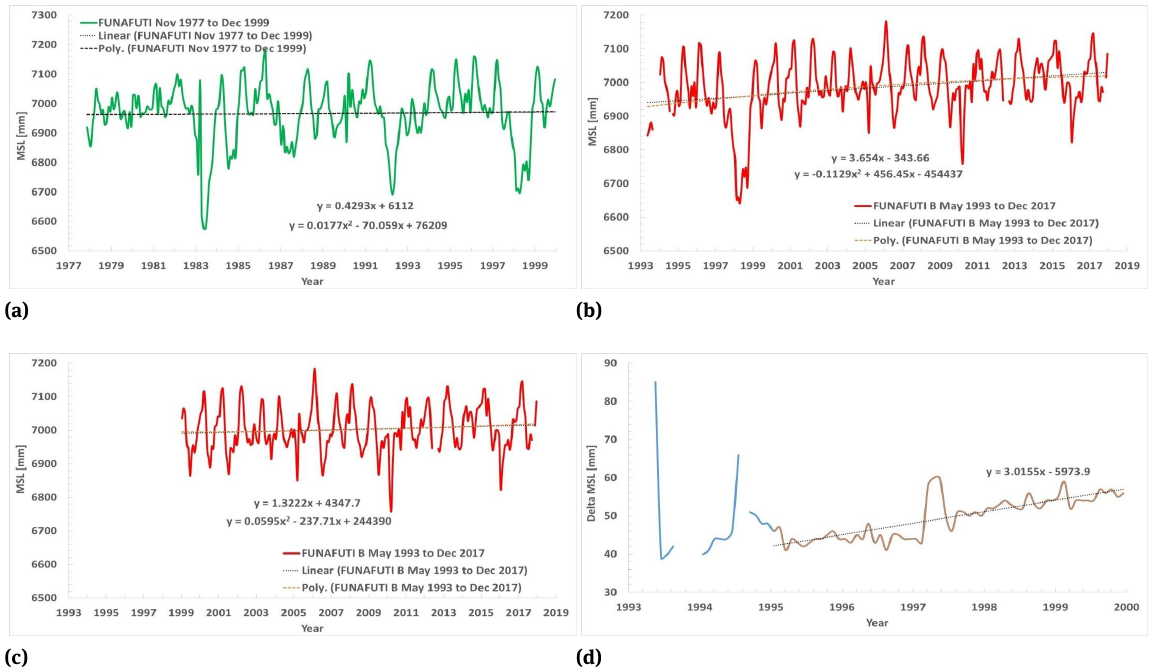
Figure 11: (a) Analysis of the FUNAFUTI tide gauge record; (b) Analysis of the FUNAFUTI B tide gauge record; (c) Analysis of the FUNAFUTI B tide gauge record with starting date Jan. 1999, after the end of the low ENSO waters; (d) differences in between the MSL of FUNAFUTI and FUNAFUTI